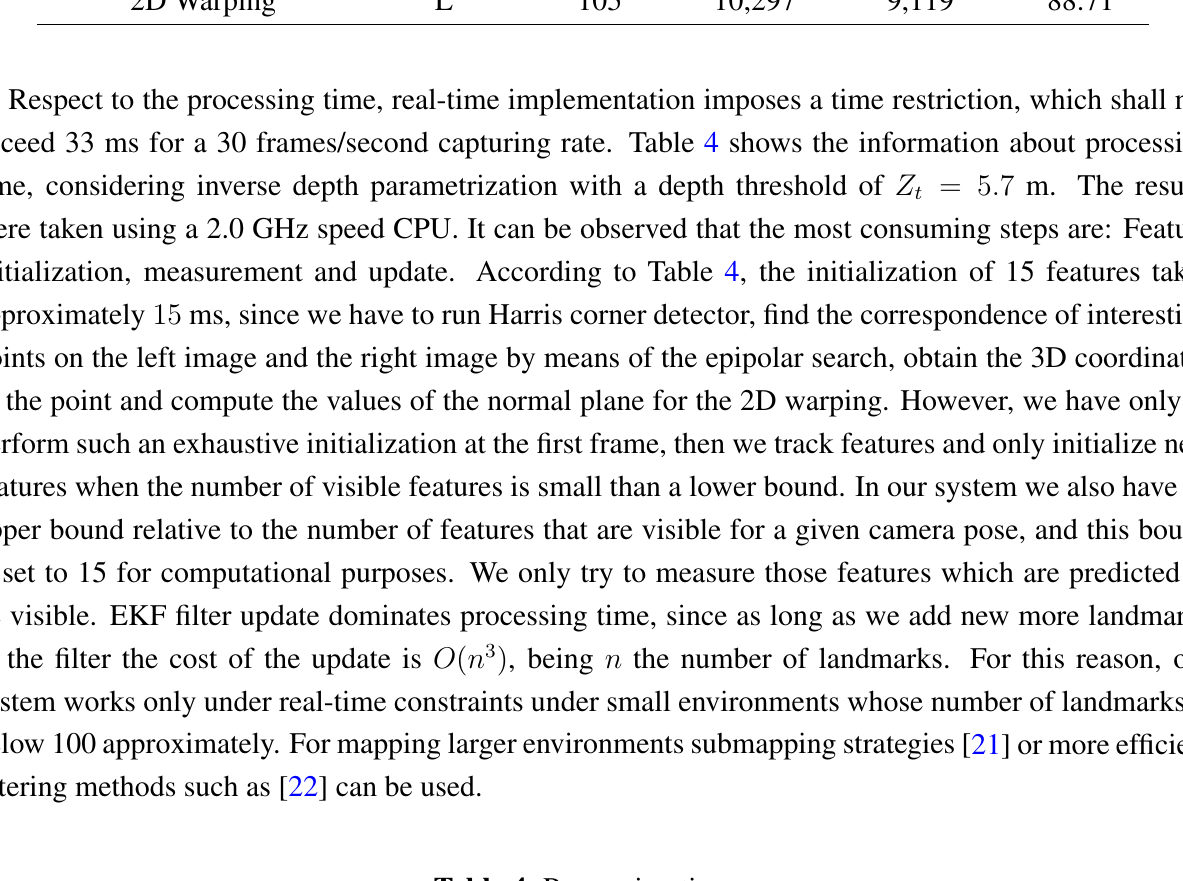
Table 4. Processing